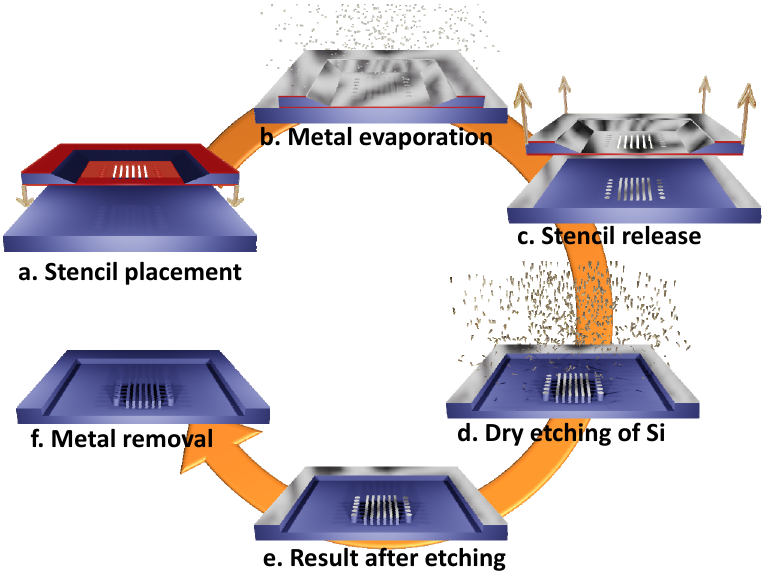
Figure 2. Nanoimprint lithography (NIL) stamp fabrication process flow. The fabrication starts with ( a ) silicon wafers, where the stencil is placed to perform ( b ) a localized deposition of metal (Al) and ( c ) subsequently removed from the substrate. A short corrective etching is performed to remove a very thin metal layer that spreads due to surface diffusion. Subsequently, the transfer of the metal patterns into the Si is performed via dry etching ( d , e ) and eventually the metal is removed via wet chemical etching ( f ). The last detail is the deposition of an anti-sticking self-assembled